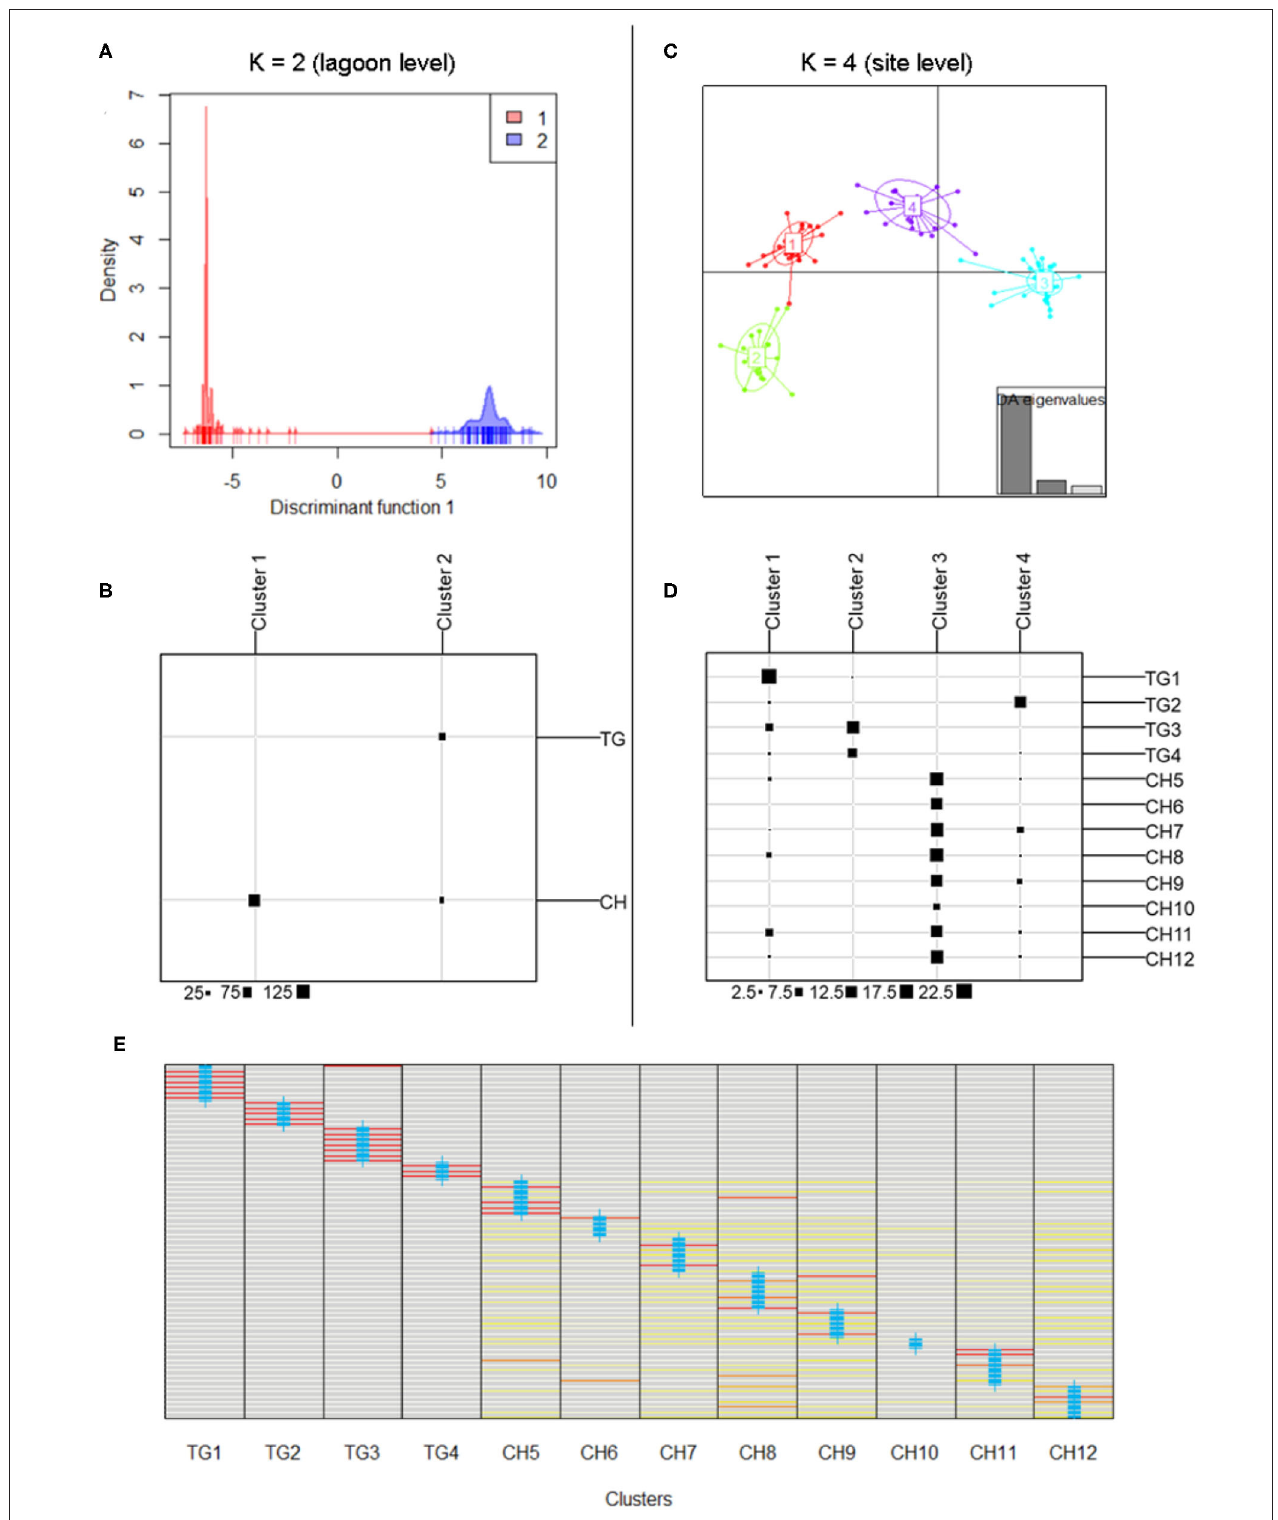
FIGURE 3 | Discriminant Analysis of Principal Components (DAPC) indicating separate clusters at lagoon level and site level. (A,B) Discriminant function of DAPC results at lagoon level with K = 2; membership of inferred clusters (columns) compared to actual groups (rows). (C,D) Scatterplot of DAPC results at site level with K = 4; membership of inferred clusters (columns) compared to actual groups (rows). (E) Comparison of individual membership between 12 newly assigned clusters and original clusters (blue crosses) (red = fully assigned to one cluster, yellow = admixed between clusters).